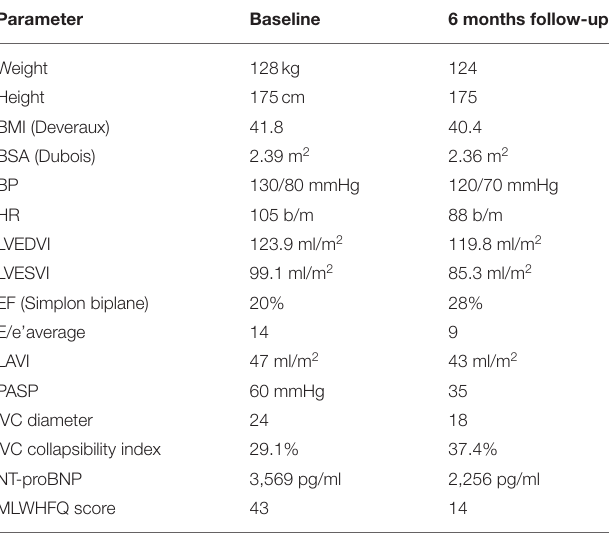
TABLE 2 | Comparison on demographic, clinical, echocardiographic and laboratory parameters between admission and 6 months follow-up. Parameter